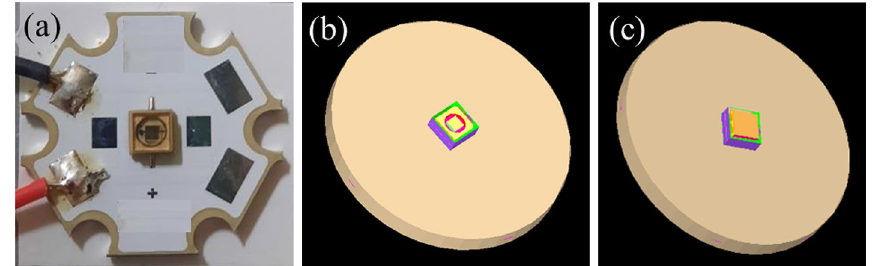
Figure 1. ( a ) UVC LED sample used for the experiment, ( b ) optical model for UVC LED without quartz window, and ( c ) with a quartz